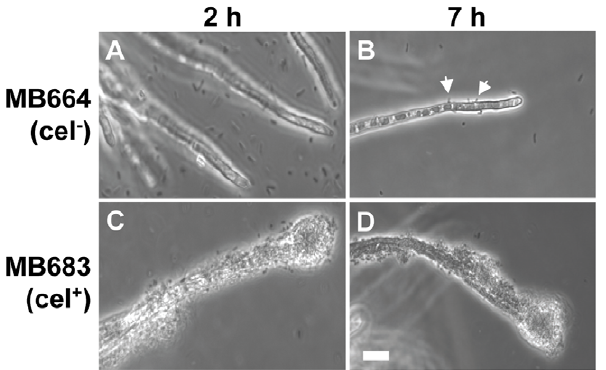
Figure 3. Comparative micrographs of the interaction of the cellulose-deficient S . Typhimurium strain MB664 (cel - , A and B) and its complemented strain MB683 (cel + , C and D), after 2 h (left panel) and 7 h (right panel) of incubation with A.niger . Strain MB664 failed to attach to the hyphae except for a few rare random cells at later time points (white arrows, B). Transformation with pMB682 restored attachment at high density and formation of a stable biofilm at later incubation times (C and D), albeit not as thick as that of the wild-type strain, as shown in figure 1D. Scale bar, 20 m m.